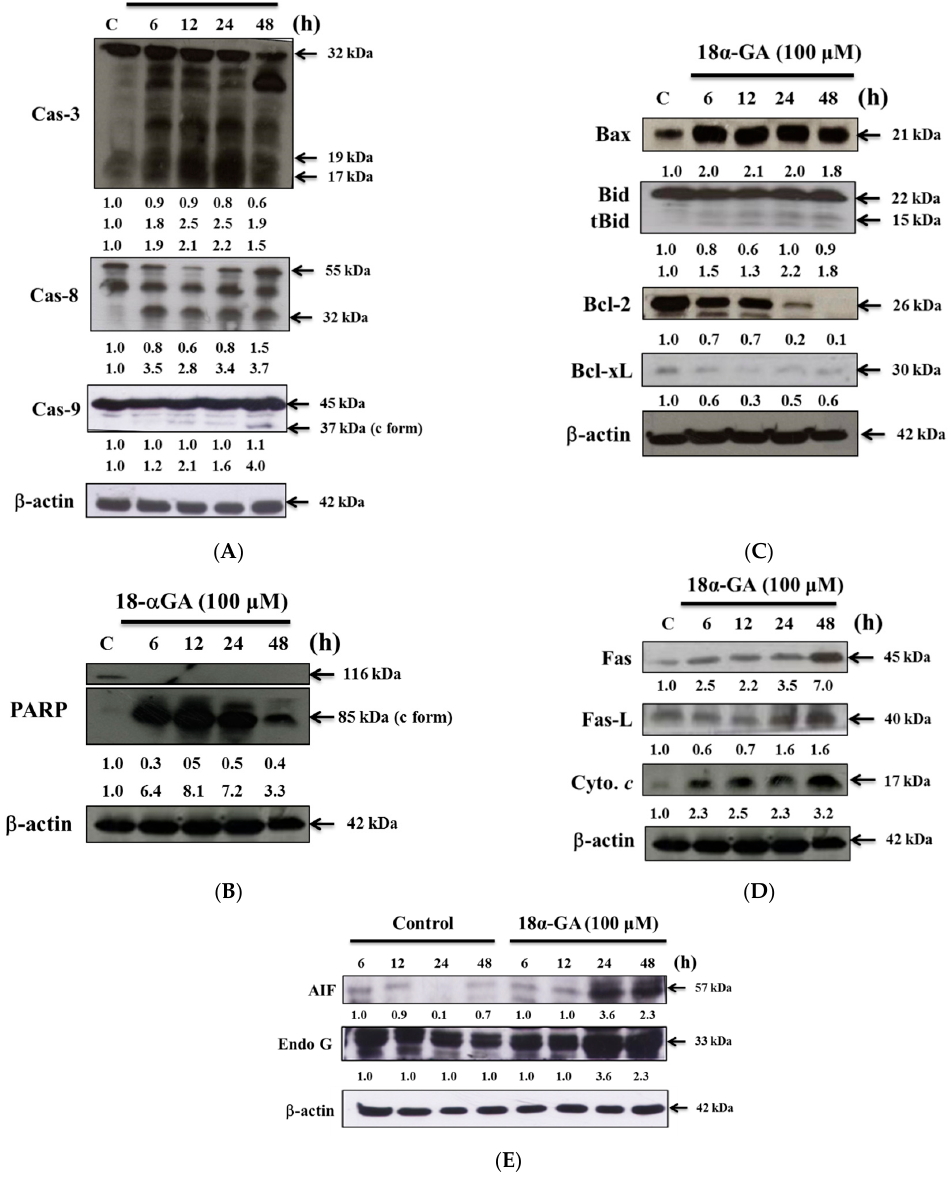
Figure 4. 18 α -GA affects apoptosis associated protein expression in HL-60 cells. Cells were treated with 18 α -GA (100 μ M) for 6, 12, 24 and 48 h and then apoptosis associated proteins were examined by western blotting as described in the Materials and Methods section. ( A ) active-caspase-8,-9 and -3; ( B ) PARP; ( C ) Bax, Bid, Bcl-2 and Bcl-xL; ( D ) Fas, Fas-L and cytochrome c (Figure 4D); ( E ) AIF and Endo G.